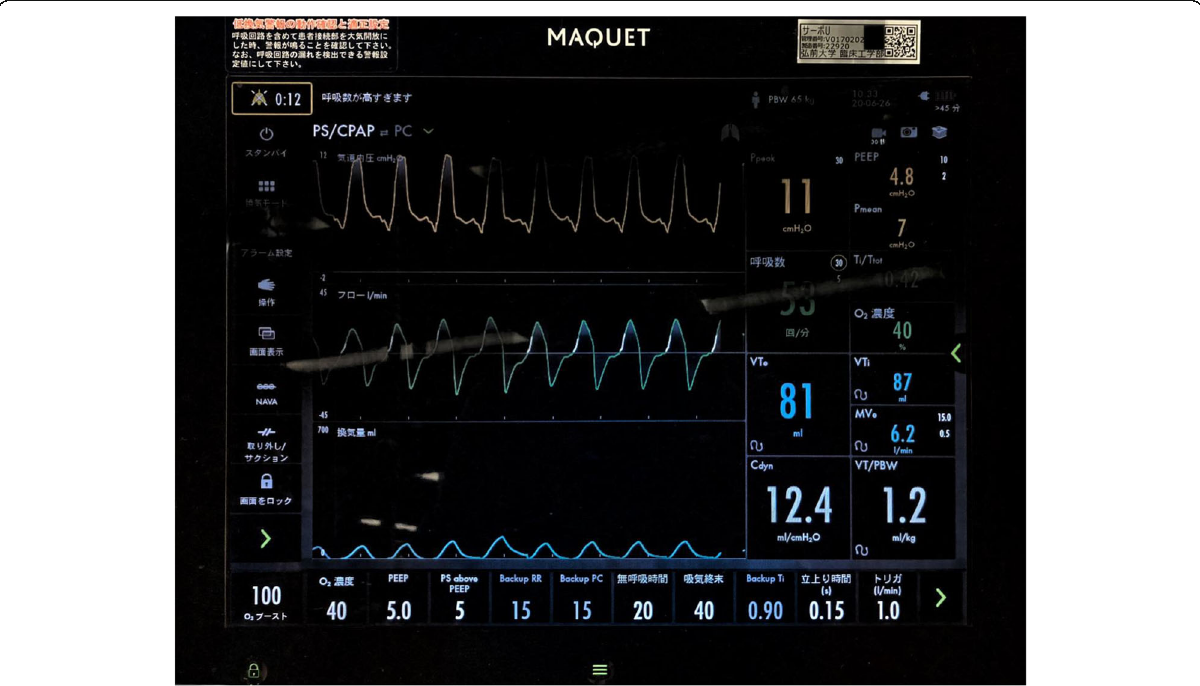
Fig. 1 The ventilator display during the first spontaneous breathing test with flow triggering. Inspiratory pressure (up), flow (middle), and tidal volume (bottom) waveforms indicate high respiratory rate (53/min) with small tidal volume (87